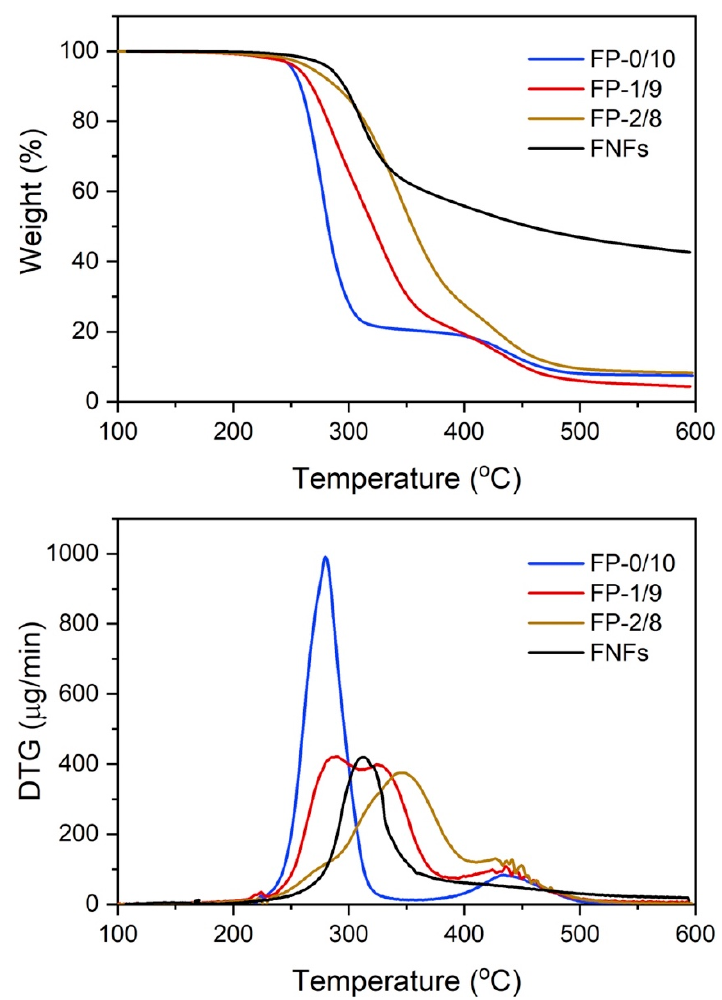
Figure 6. TG and DTG curves for PVA, FNFs, and FNF/PVA composite nanofibers.